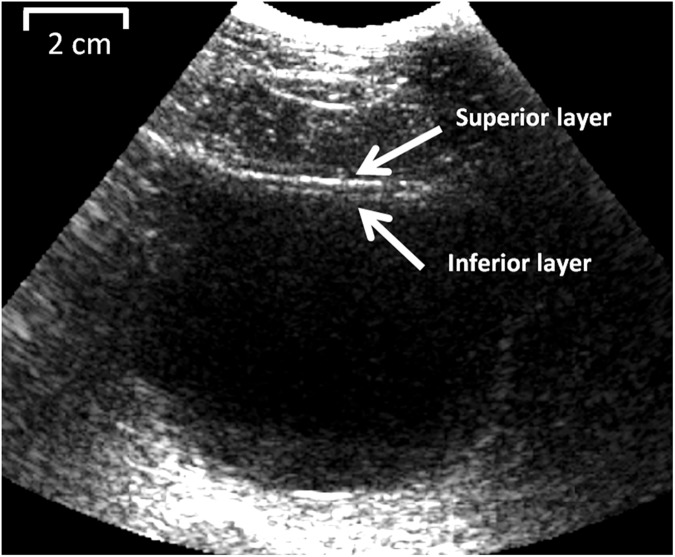
Bladder cavity and detrusor layer (inferior layer) as seen in the B-mode ultrasound image.